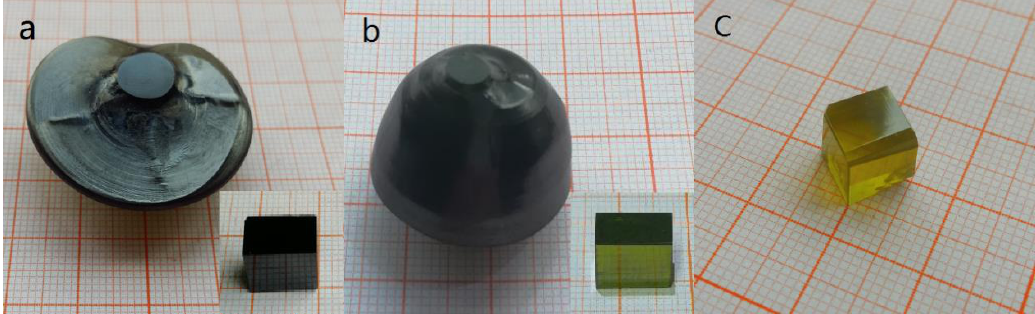
Figure 1. Photographs of as-grown CeAlO 3 crystals: ( a ) grown at pure Ar atmosphere, ( b ) grown at + 95% Ar atmosphere, ( c ) annealed 5% H 2 + 95% Ar atmosphere, ( c ) annealed sample. H 2